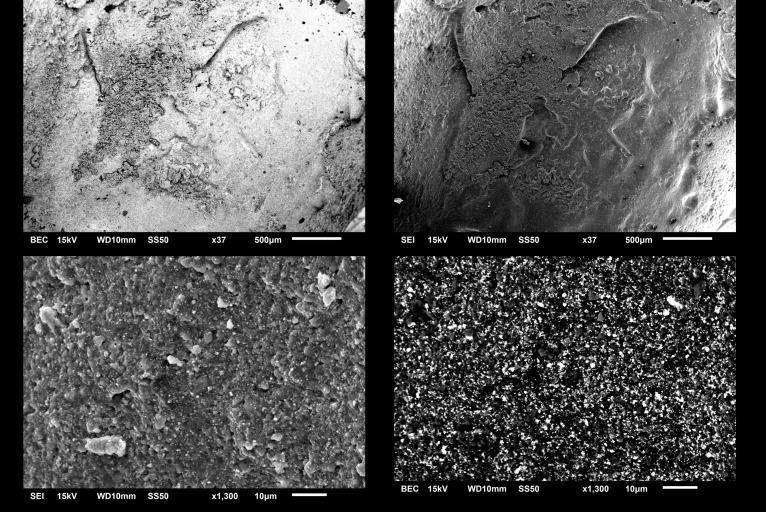
SEM Images of lithium disilicate crown after irradiation at 500μm and 10μm scale, note intact surface with residual cement.Top left and right demonstrates undamage smooth lithium disilicate material with some residual cement 500μm scale. Bottom left and right demonstrates normal crystal structure of lithium disilicate at 10μm.